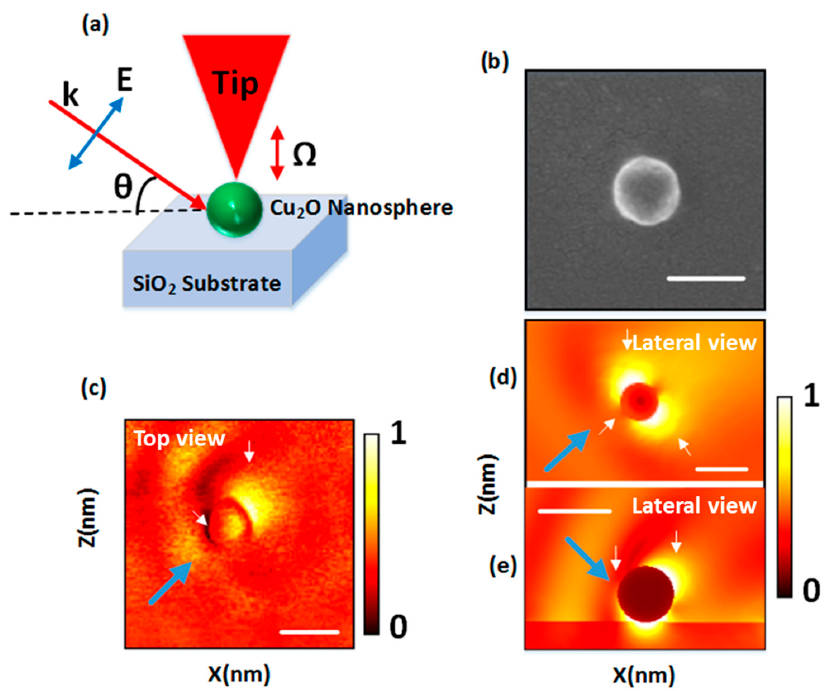
Figure 8. ( a ) A schematic of apertureless scanning near-field optical microscopy (ASNOM). A plane polarized light at the wavelength of 632 nm was used as incident field with an angle of incidence of 33 ◦ . ( b ) SEM image of the sample under test, ( c ) experimental image of the scattered amplitude delivered by ASNOM. The color bar is normalized with respect to the maximum value, and the length of the scale bar is 200 nm. This image shows a top view of the sample under test. ( d , e ) Simulated scattering amplitude without and with substrate, respectively, shown for comparison. These images are a lateral view of the sample on the XZ plane. Blue big arrows label the direction of the incident beam, while small white arrows highlight important features in the results.